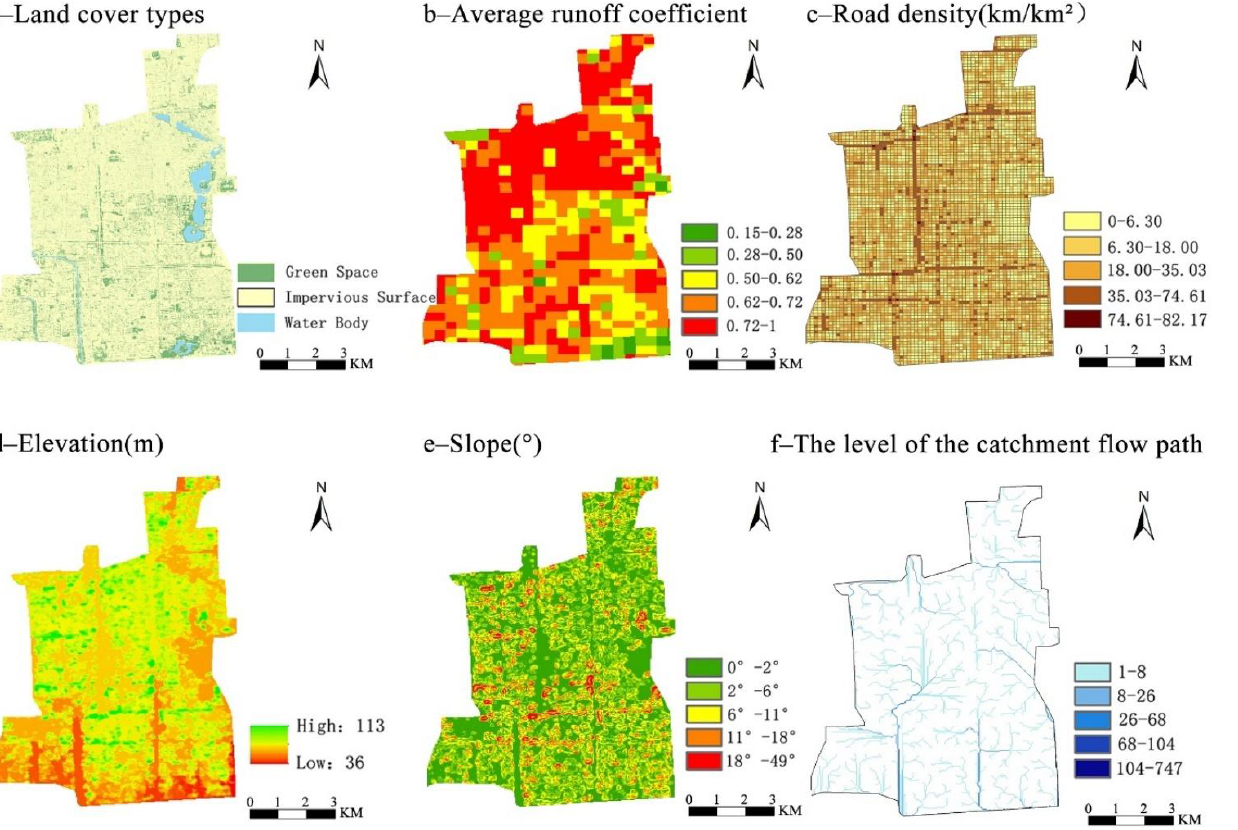
Table 6. Grading situation and evaluation values of influence indicators in the selection of a multi-functional rainwater storage space site.